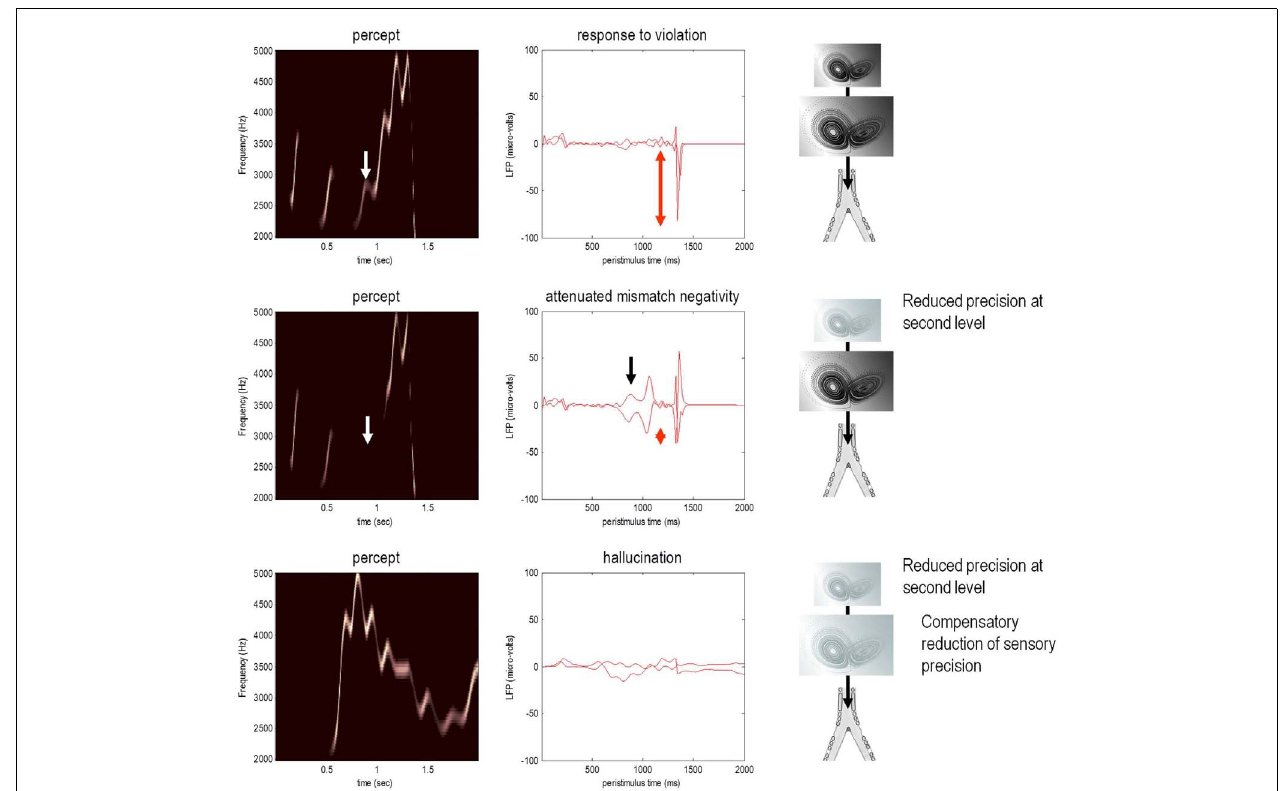
bottom-up sensory evidence and sensory prediction errors are resolved under reduced top-down constraints. At the same time, the third chirp – that would have been predicted on the basis of top-down (empirical) prior beliefs – is missed, leading to sensory prediction errors that nearly match the amplitude of the prediction errors elicited by the omission.The lower row shows predictions and prediction errors when there is a compensatory decrease in sensory log precision from two to minus two. Here, there is a failure of sensory prediction errors to entrain high-level expectations and subsequent false inference that persists in the absence of any